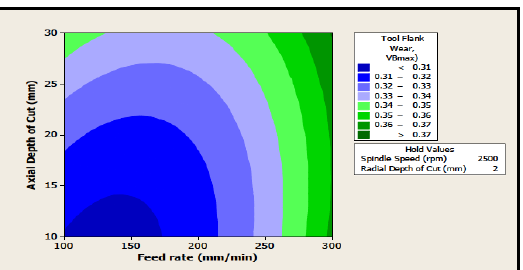
Figure 5: Contour plot of tool wear vs. Radial depth of cut and spin- dle speed.